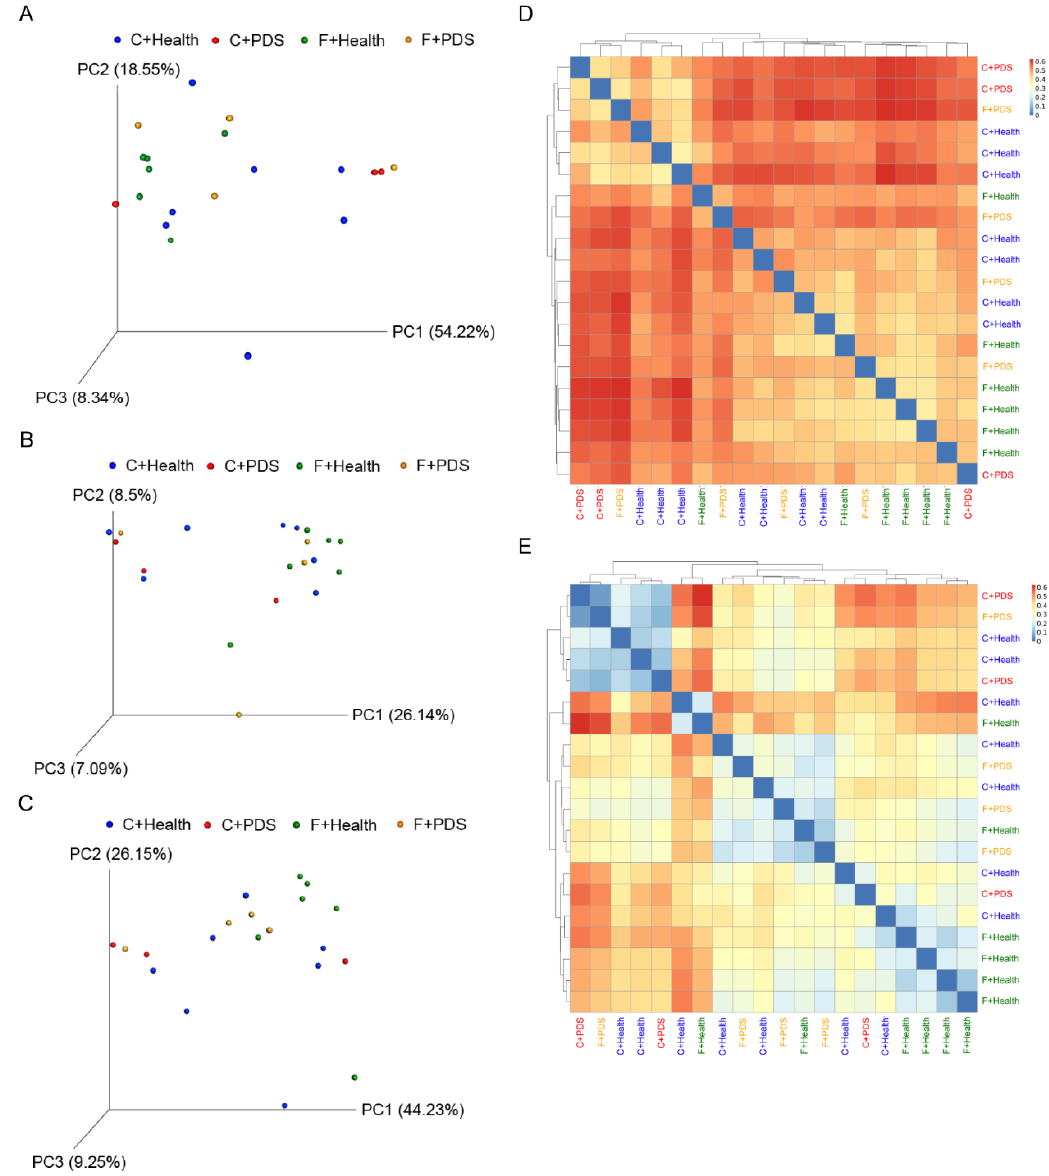
Figure 2. Microbial composition analysis of fecal content. ( A ) Principal component analysis plot of